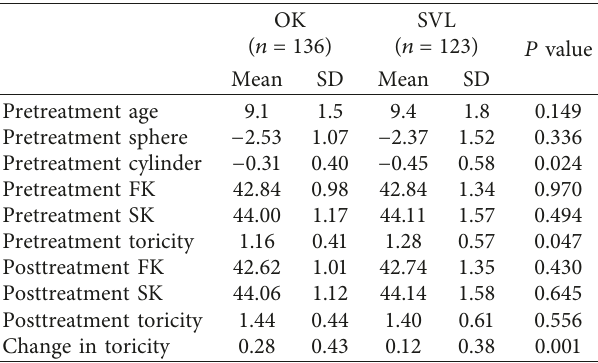
Figure 3: Corneal topography maps from a representative subject who experienced a significant increase in corneal toricity and a change in overall corneal shape in the right eye after discontinuation of ortho-k lens wear (a) as compared to pre-ortho-k value (b). Table 1: Comparison of refractive error and corneal curvature between the ortho-k and control